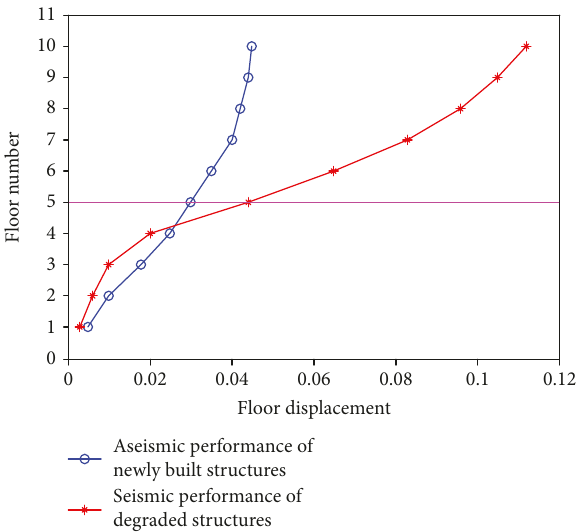
Figure 10: Traditional seismic performance evaluation and seismic performance evaluation under a Hadoop